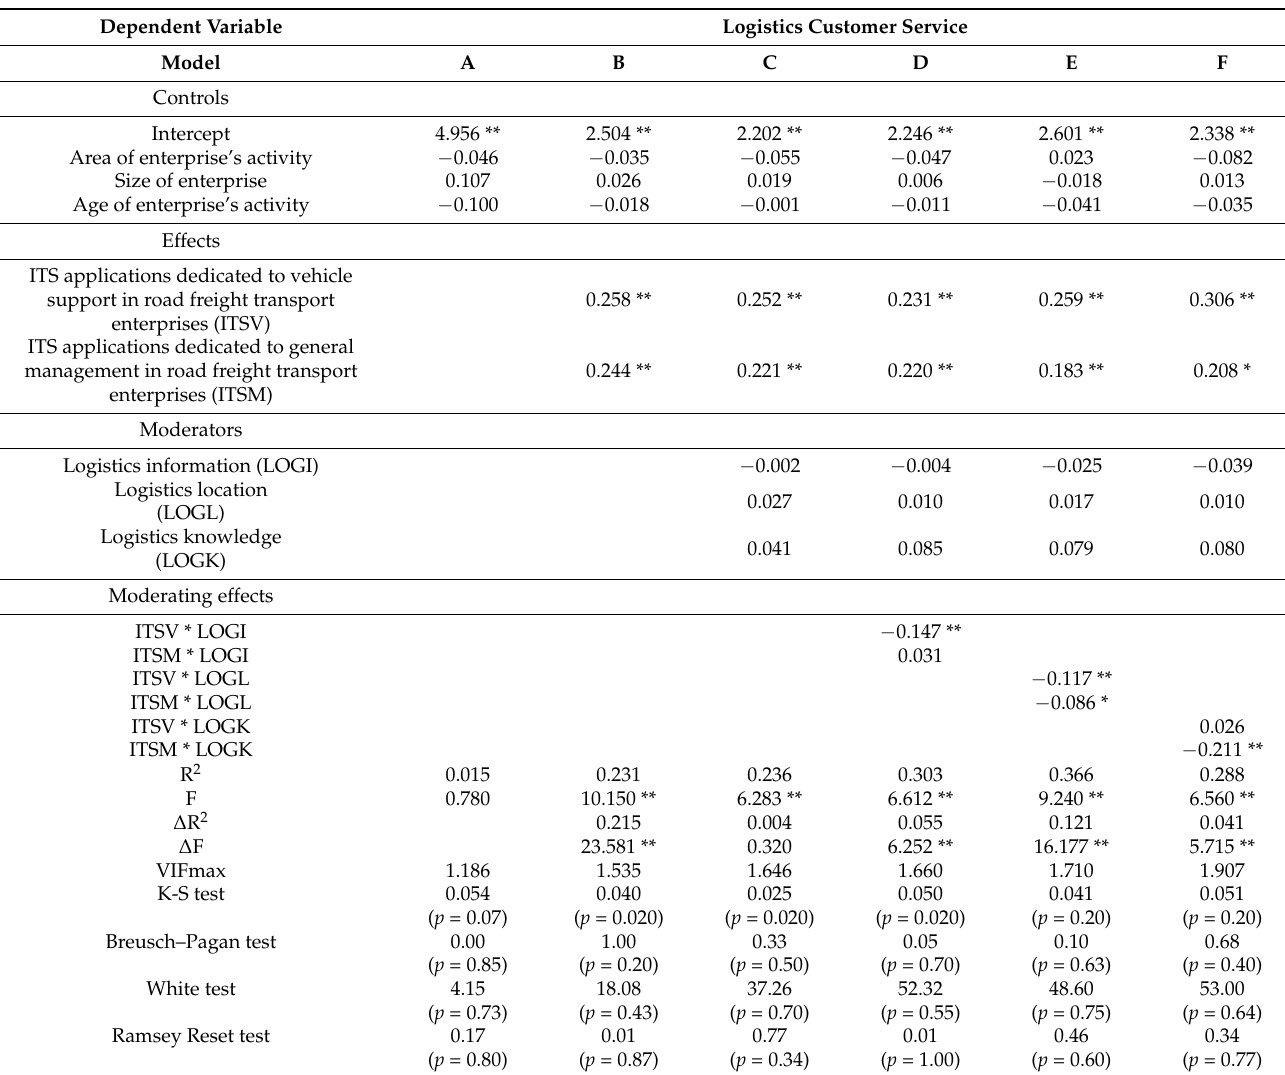
Table 5. Results of hierarchical multiple regression.